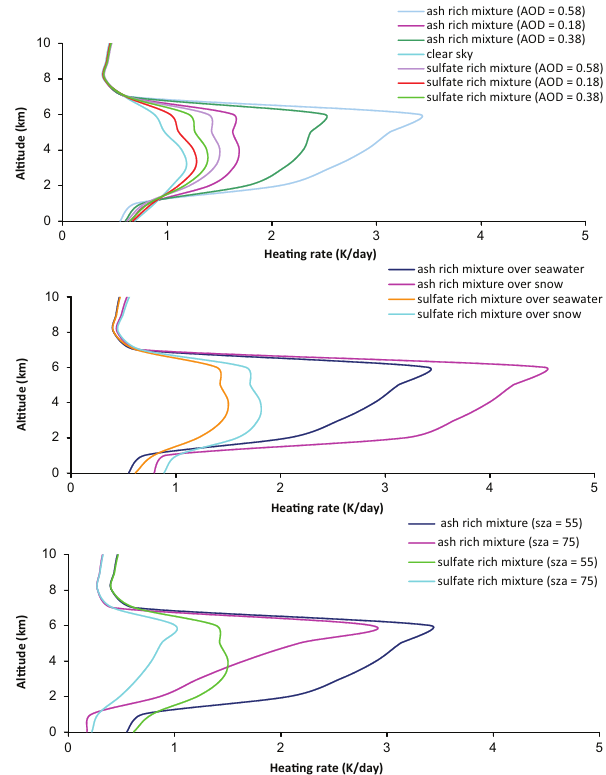
Fig. 8. (a) The effect of aerosol composition and AOD(550 nm) of a thin plume ( ∼ 2.5–7km) on SW heating rate. SZA=55 ◦ and surface type is seawater for all cases. (b) The effect of aerosol composition of a thin plume ( ∼ 2.5–7km) and surface type on SW heating rate. SZA = 55 ◦ and AOD (550nm)=0.58 for all cases. (c) The effect of aerosol composition of a thin plume (~2.5–7km) and solar zenith angle (SZA) on SW atmospheric heating rate. The AOD(550nm)=0.58 and the surface type is seawater for all cases.